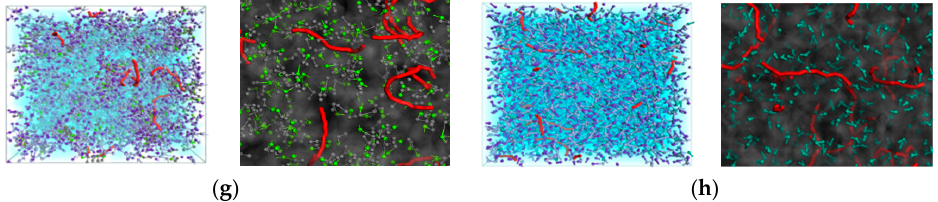
Figure 3. Morphologies of the systems formed at a dendrimer-to-siRNA charge ratio (N/P) = 10 by the siRNA molecules and the amphiphilic dendrons 1 ( a ), 2 ( b ), 3 ( c ), 4 ( d ), 5 ( e ), 6 ( f ), 7 ( g ) and 8 ( h ) as obtained from molecular simulations. Left panels are zoomed images of the right panels. Colors as in Figure 2, except for the siRNA molecules, shown as red sticks and the water and counterions, portrayed in the left panels as light blue field for clarity. Adapted from [7] with the permission of John Wiley and Sons, 2016.